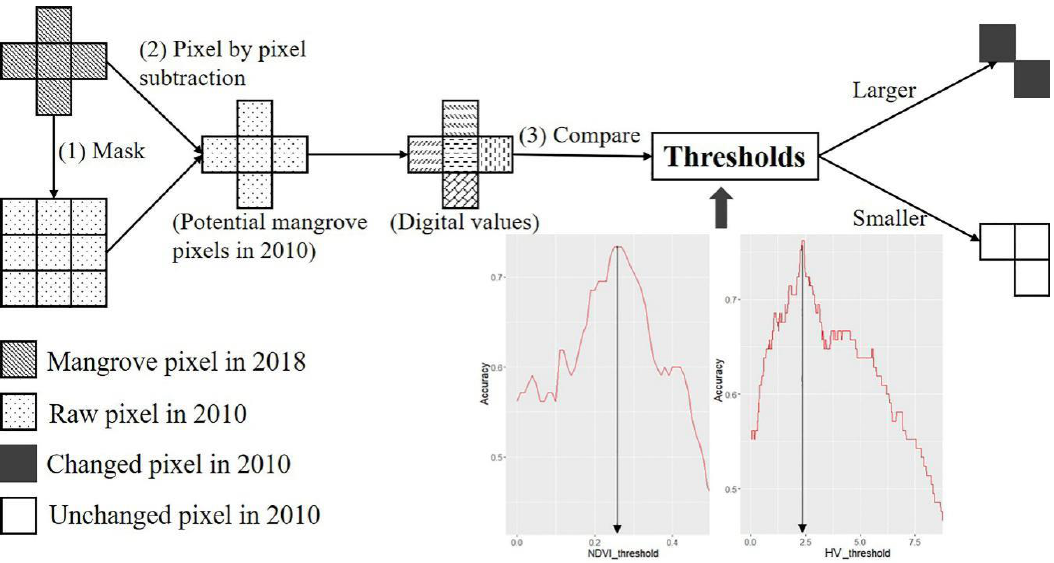
Figure 3. The schematic diagram of mangrove change detection (2010–2018).